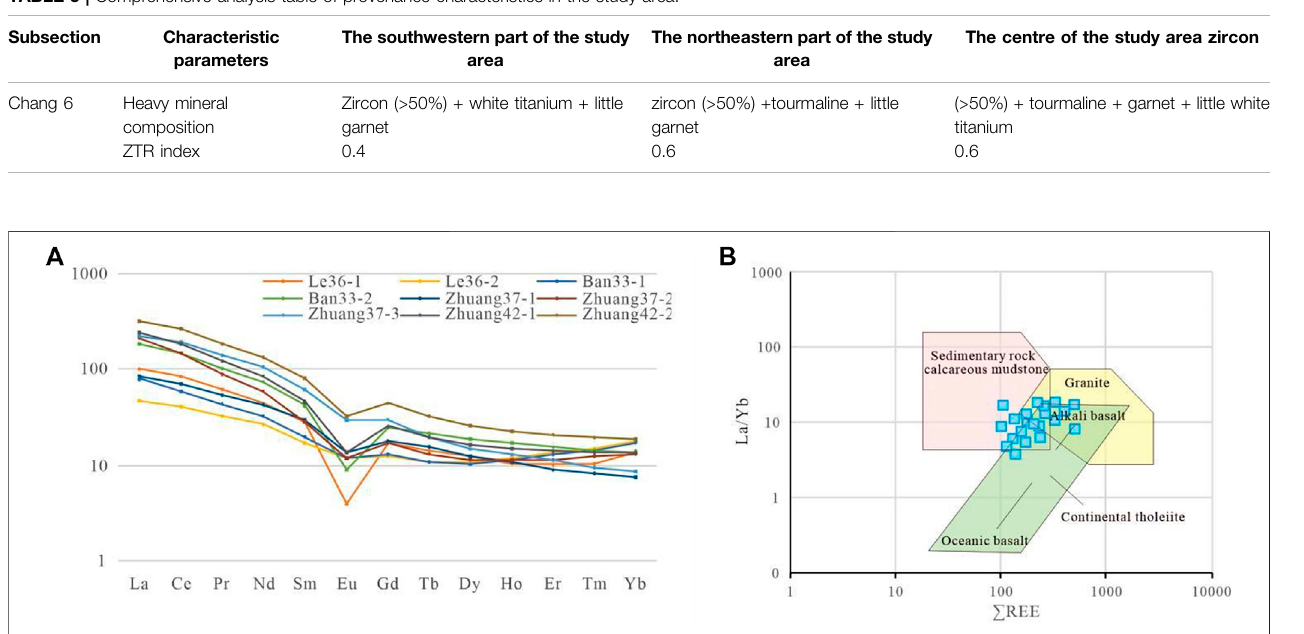
TABLE 5 | Comprehensive analysis table of provenance characteristics in the study area.